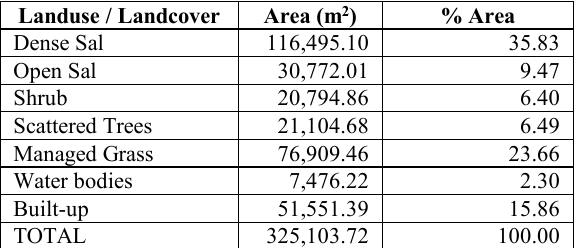
Table 2. Area statistics of Landuse Landcover classes.